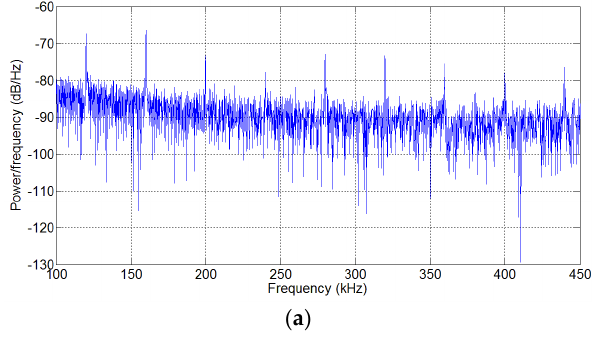
Figure 28. Cont. Figure 28.